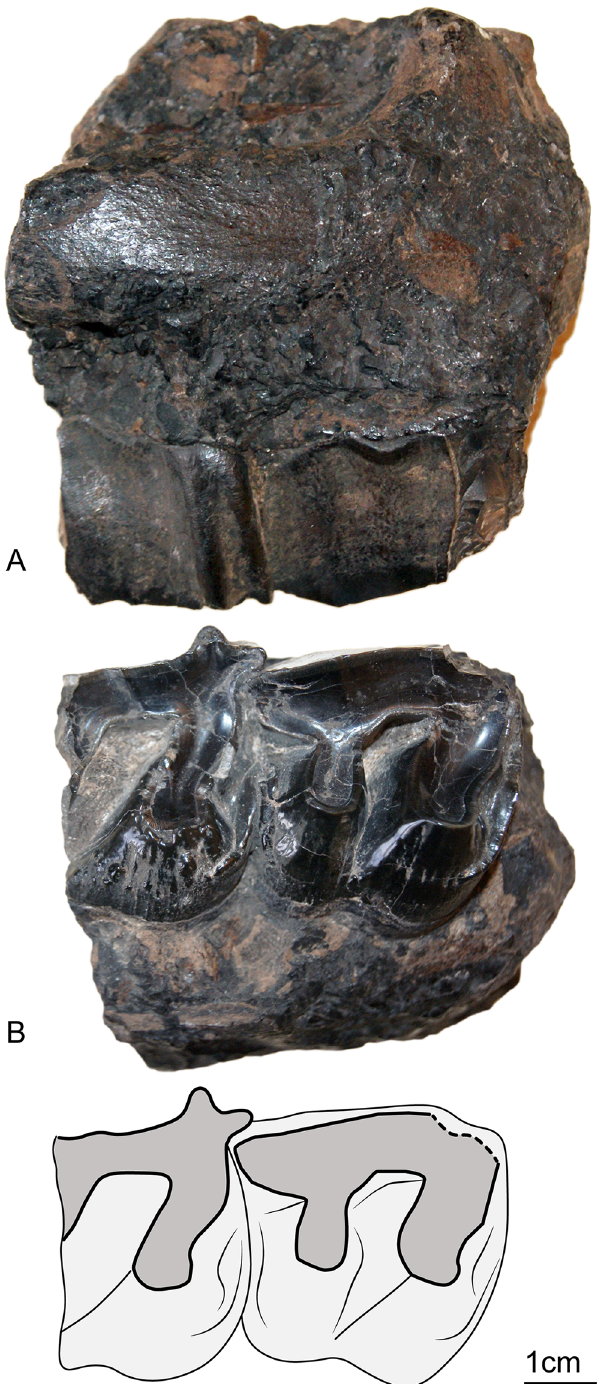
Fig 7. Amynodontopsis aff. bodei from Dorog (late Middle Eocene; Hungary). A-B: Right maxillary fragment (HNHM PAL 2017.54.1) with upper M2-3 in labial (A) and occlusal (B) views.